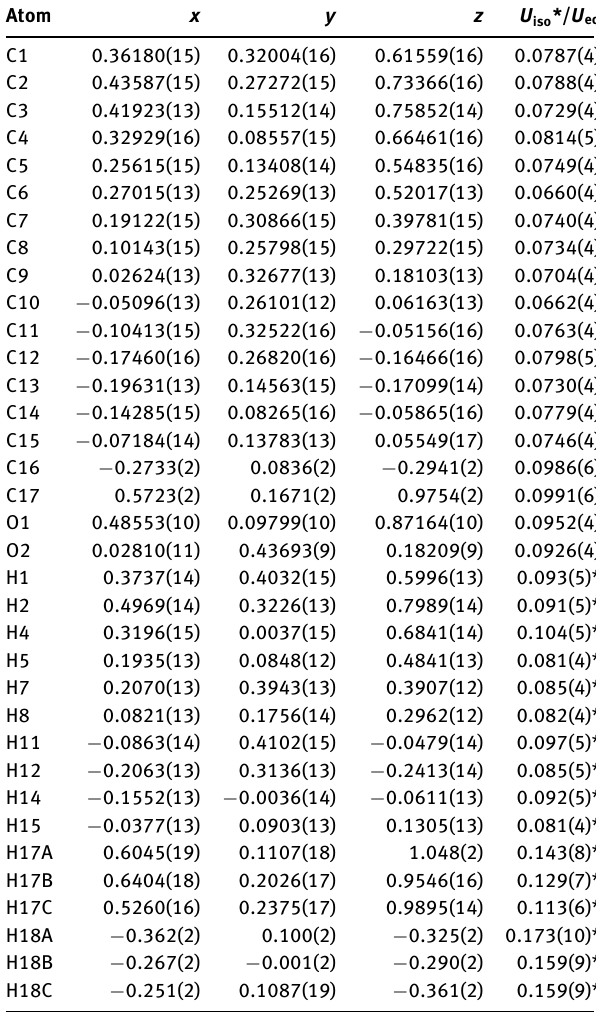
Table 2: Fractional atomic coordinates and isotropic or equivalent isotropic displacement parameters (Å 2